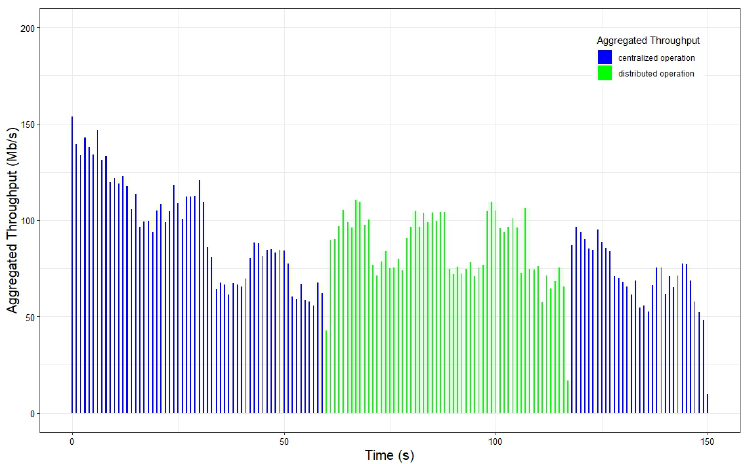
Figure 20. Aggregated throughput behavior over time during network operation switching in